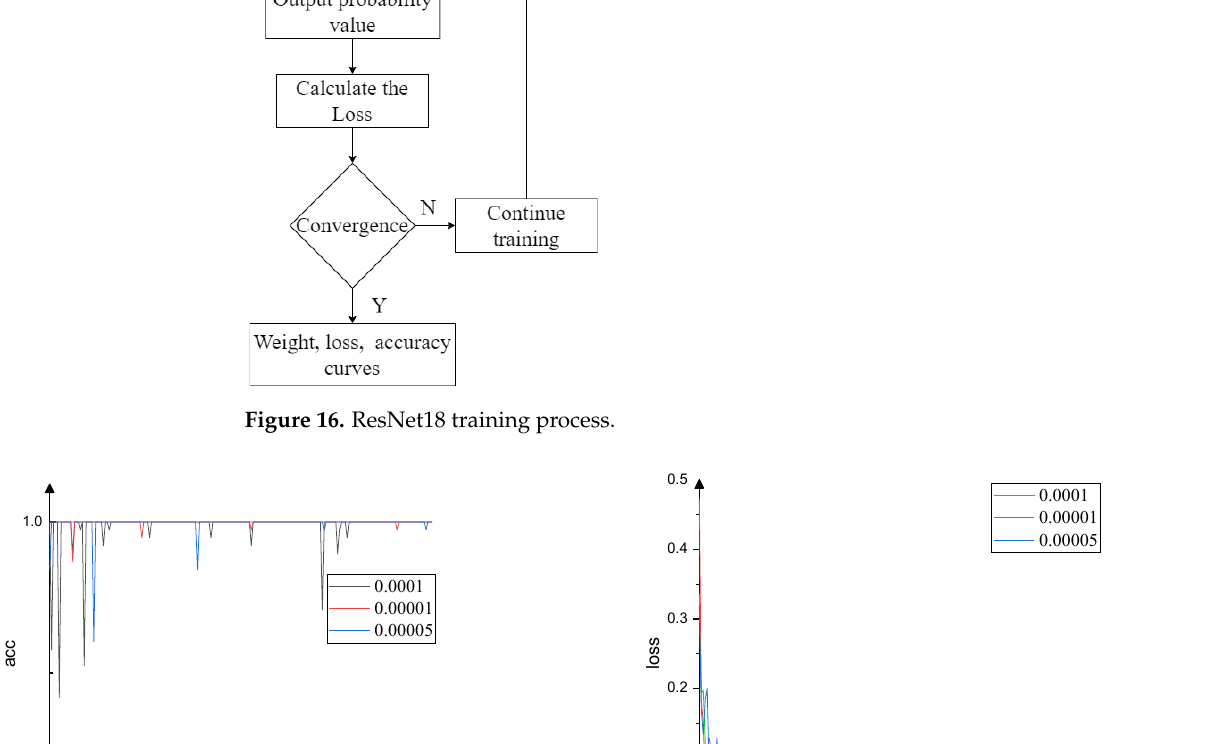
Figure 16. ResNet18 training process.